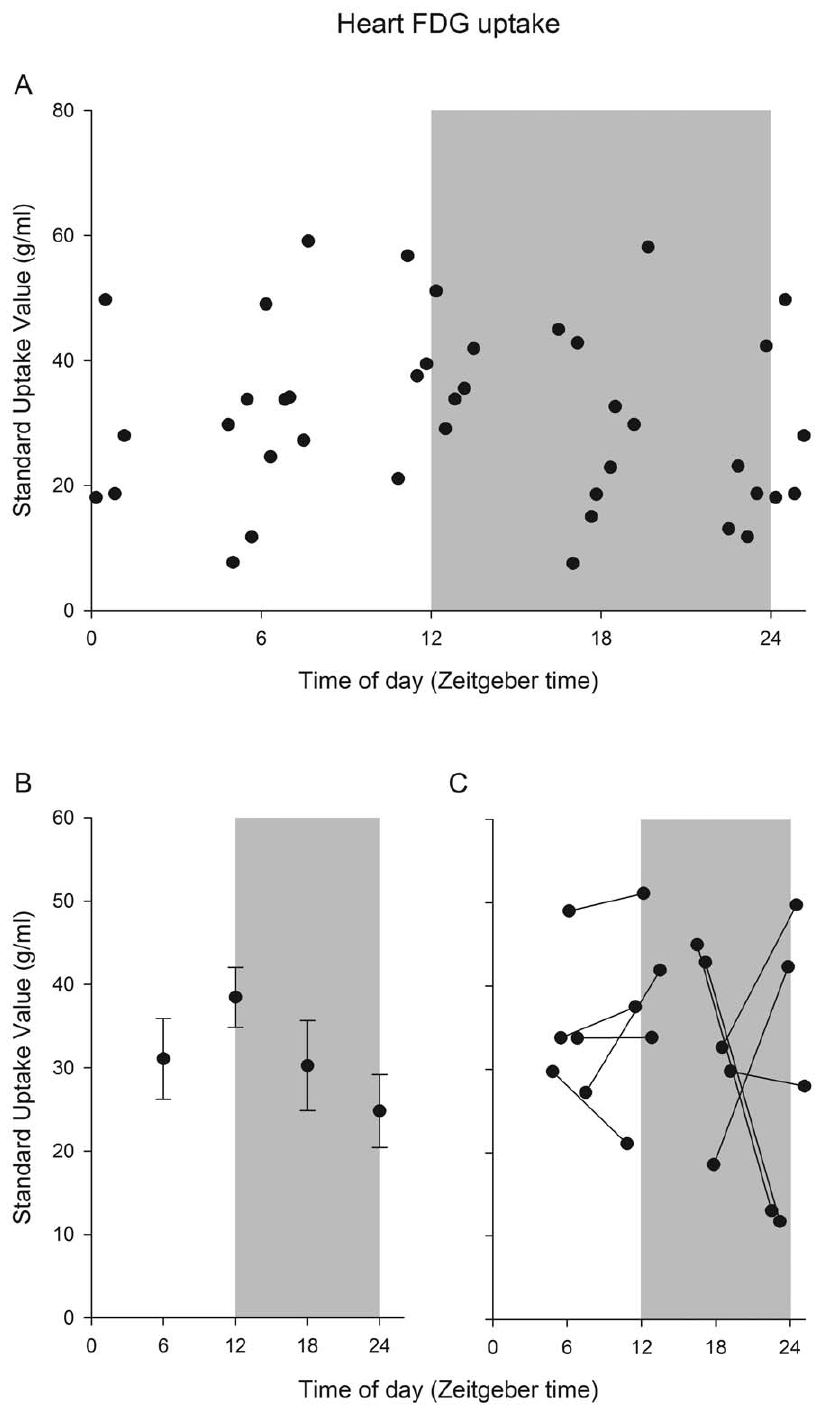
Figure 3. Time-of-day specific analysis of FDG uptake in heart. (A) Whole heart FDG uptake in the same C57Bl/6 mice as Figure 2 (N=37) plotted at the time of measurement. There is no statistically significant variation of total FDG uptake for grouped averages (B). The within individual comparison (C) also shows no uniform FDG uptake at different times of the day. doi:10.1371/journal.pone.0031792.g003 glucose utilization as quantified using the 2-DG method during the indicative of an antiphase rhythm specifically in the SCN, that light phase rather than during the night [9,14,17]. While the would quench the rhythmic profile expressed in the remaining hypothalamic nuclei. The low amplitude in both left and right spatial resolution and ‘partial voluming effect’ [26] of our technique is not sufficient to identify brain regions on such a amygdaloid FDG uptake may again be caused by rhythms in small scale, the below-average amplitude in the hypothalamus is specific amygdaloid nuclei exhibiting different peak phases. This